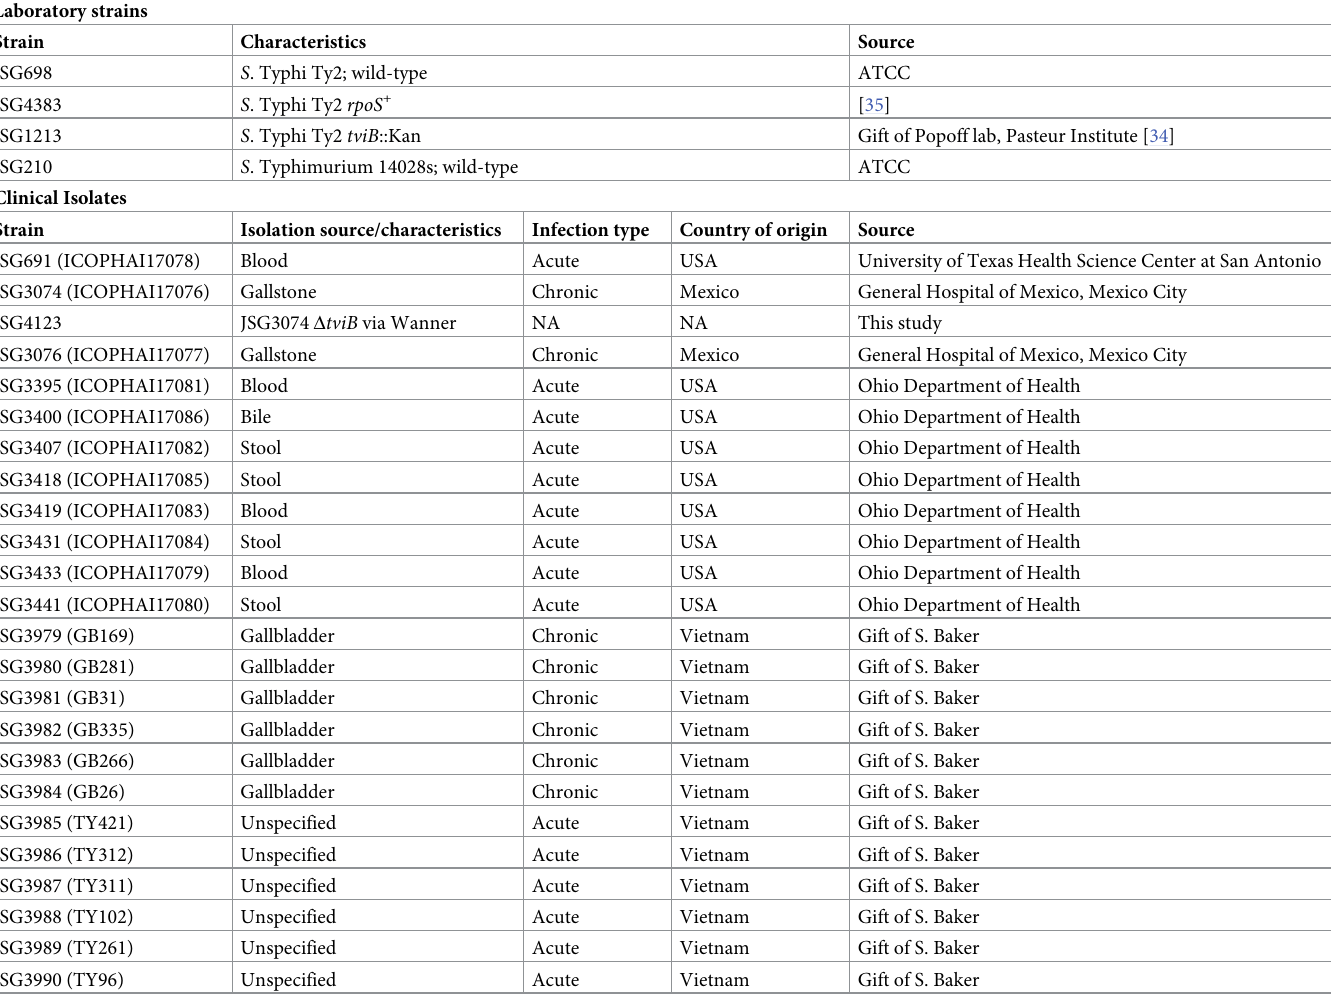
Table 1. Strains used in this